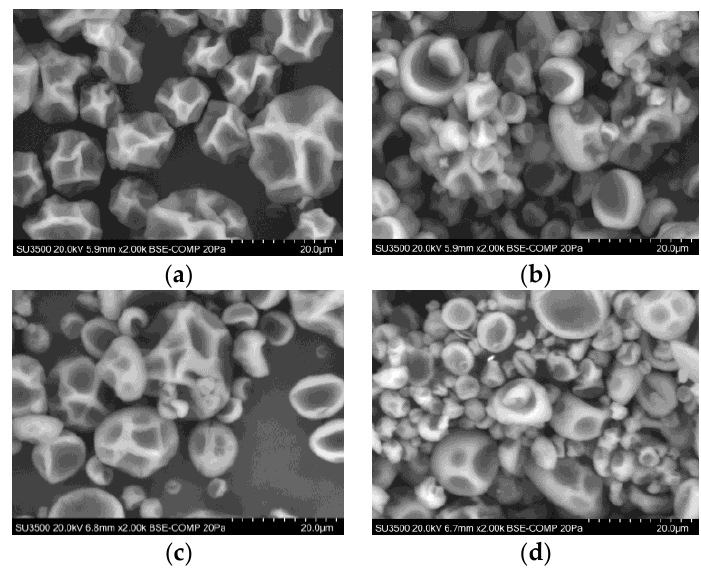
Figure 4. Scanning electron microscopy images of spray-dried particles containing probiotics stored for 1 day at 4 ◦ C. The spray-drying process was conducted with an encapsulating solution that contained maltodextrin (14.4% w / v) and chia seed mucilage (0.6% w / v) and dried with an inlet air temperature of 90 ◦ C. ( a ) L. rhamnosus , ( b ) L. plantarum , ( c ) B. infantis , and ( d ) B. longum .